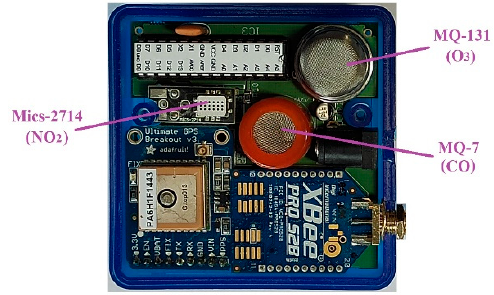
Figure 1. Telemetering devices from the EcoBici